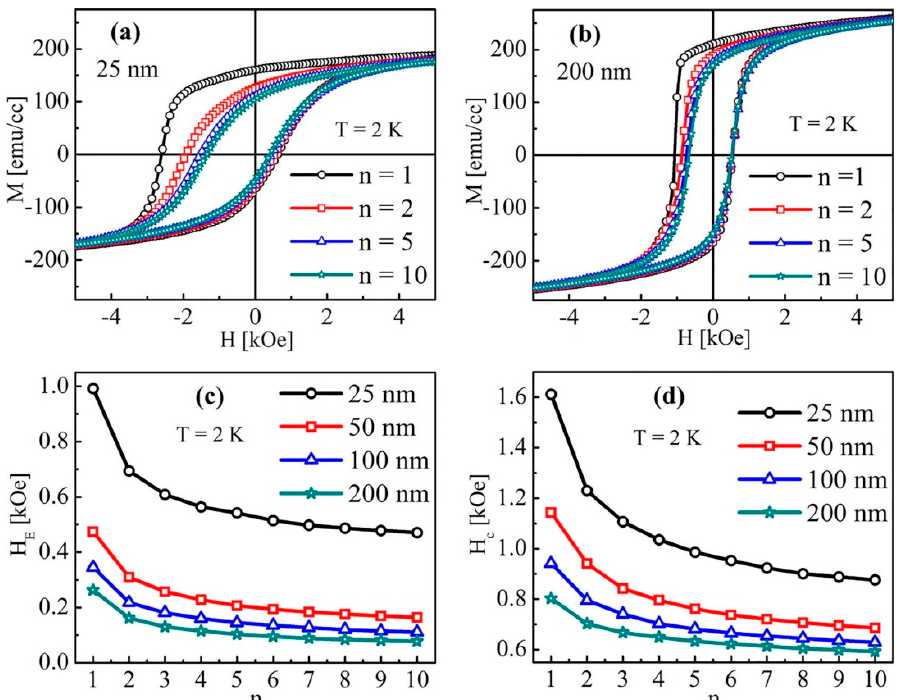
Figure 11. Hysteresis loops, measured at T = 2 K after field cooling for a Fe 3 O 4 film thickness of (a) 25 nm, ( b ) 200 nm; dependence of ( c ) the exchange bias field HE, ( d ) the coercive field HC on the number of cycles. Reprinted with permission from [113], Copyright 2018 Elsevier.